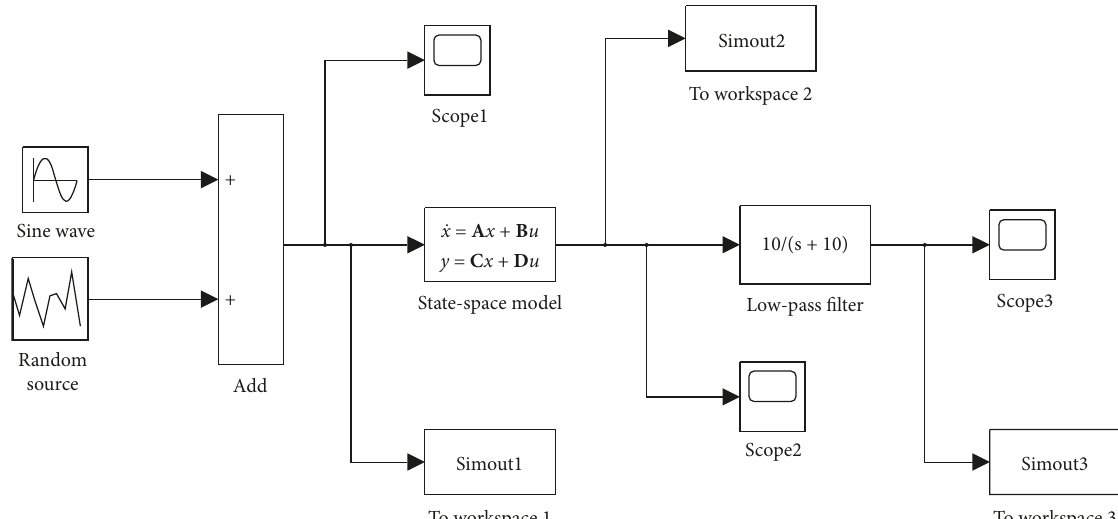
Figure 18: Simulink block diagram for the beam system model with sensor noise filter.